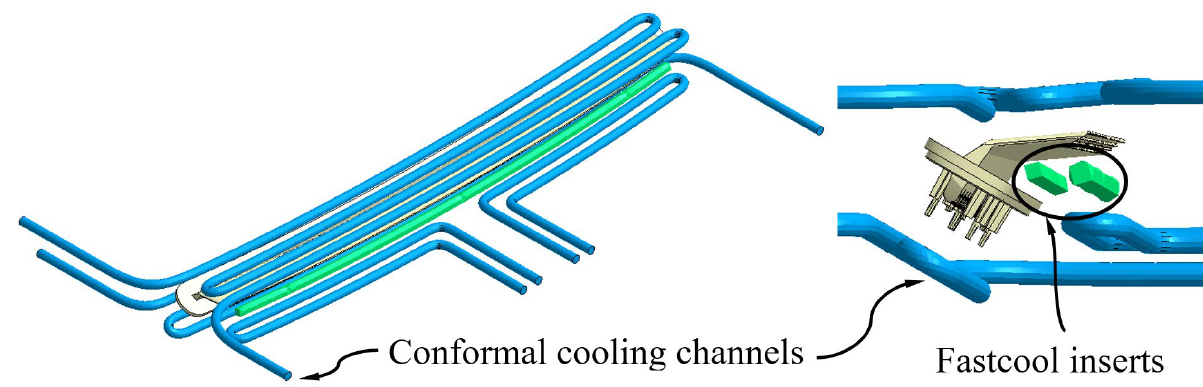
Figure 8. Hybrid cooling system design, Fastcool full bars.